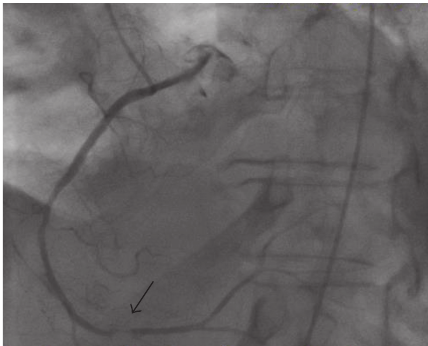
Figure 5: Cardiac catheterization image of the right coronary artery demonstrating a significant filling defect in the distal artery.